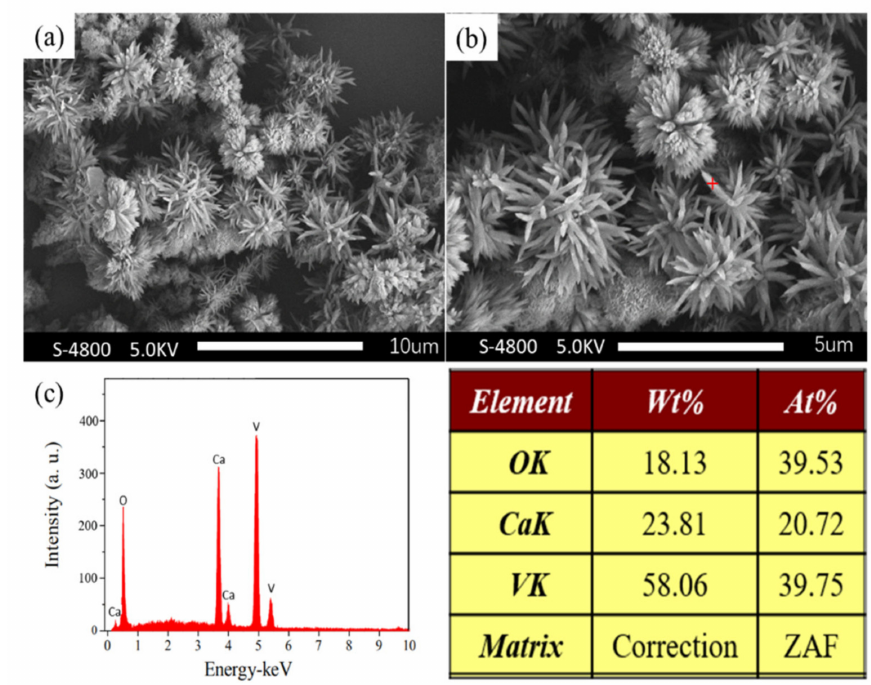
Figure 13. Surface morphology and energy spectrum analysis of calcification products (( a , b ) CaV 2 O 6 surface morphology under different magnifications; ( c ) analysis of the energy spectrum points in the Figure 13( b